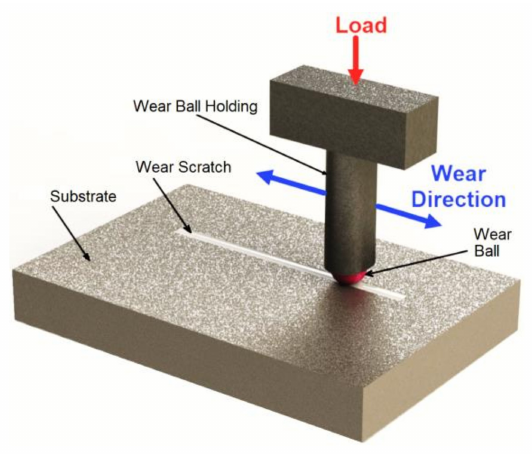
Figure 1. Schematic view of reciprocating wear